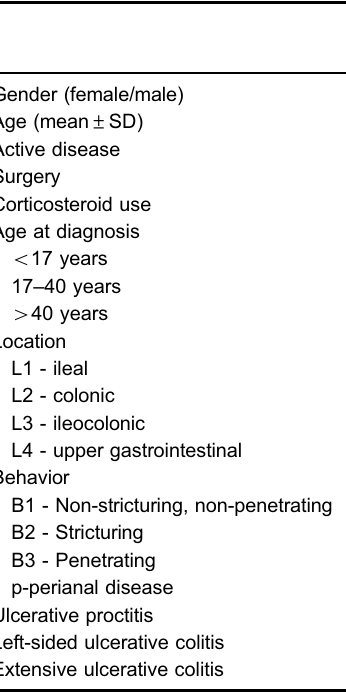
Table 1. Baseline characteristics of patients and